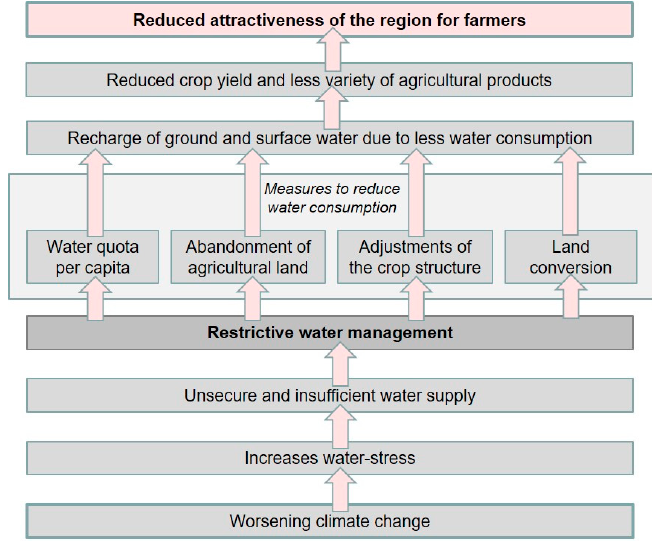
Figure 6. The impact of the restrictive water management on rural areas (own figure).